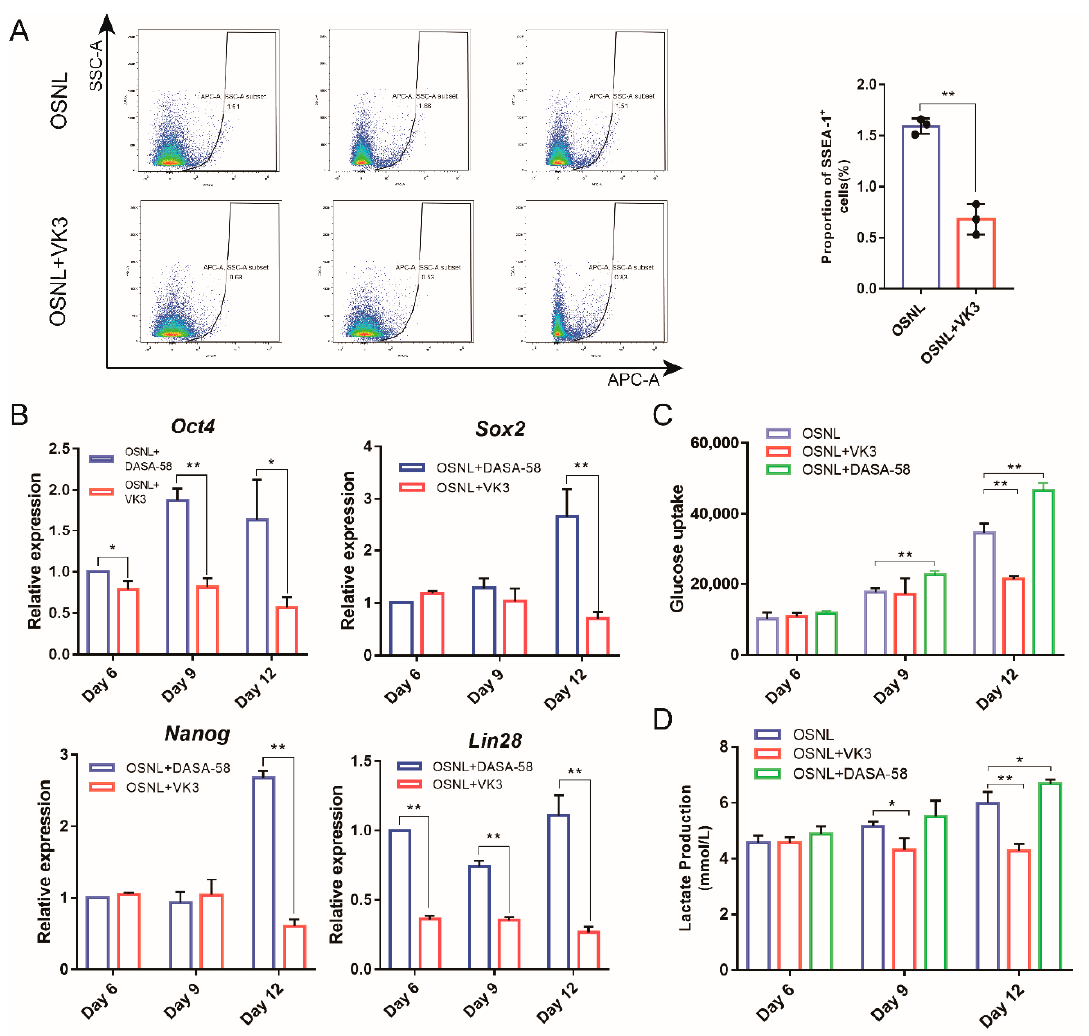
Figure 5. Glycolysis activates the expression of endogenous pluripotent genes to promote the formation of chicken iPSCs. ( A ) The proportion of SSEA-1 positive cells after adding glycolytic inhibitor VK3 detected by flow cytometry. ( B ) qRT-PCR analysis of expression of pluripotent genes Oct4 , Sox2 , Nanog and Lin28 after adding glycolytic activator DASA-58 or glycolytic inhibitor VK3. ( C ) Changes in glucose uptake after adding glycolytic activator DASA-58 or inhibitor VK3. ( D ) Changes in lactate production after adding glycolytic activator DASA-58 or inhibitor VK3. * represents p < 0.05 and ** represents p < 0.01.